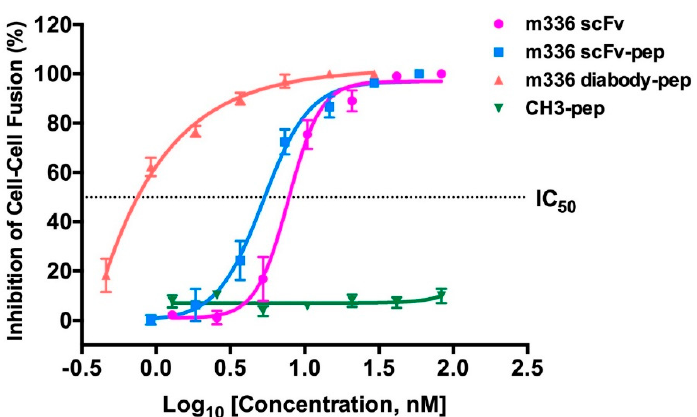
Figure 4. Inhibitory activity of anti-MERS-CoV inhibitors on MERS-CoV S protein-mediated cell-cell fusion. The number of 293T/MERS/EGFP cells fused or unfused with Huh-7 cells were counted, and the percentage of inhibition was calculated.